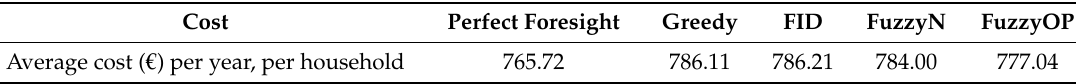
Table 5. The average costs of different